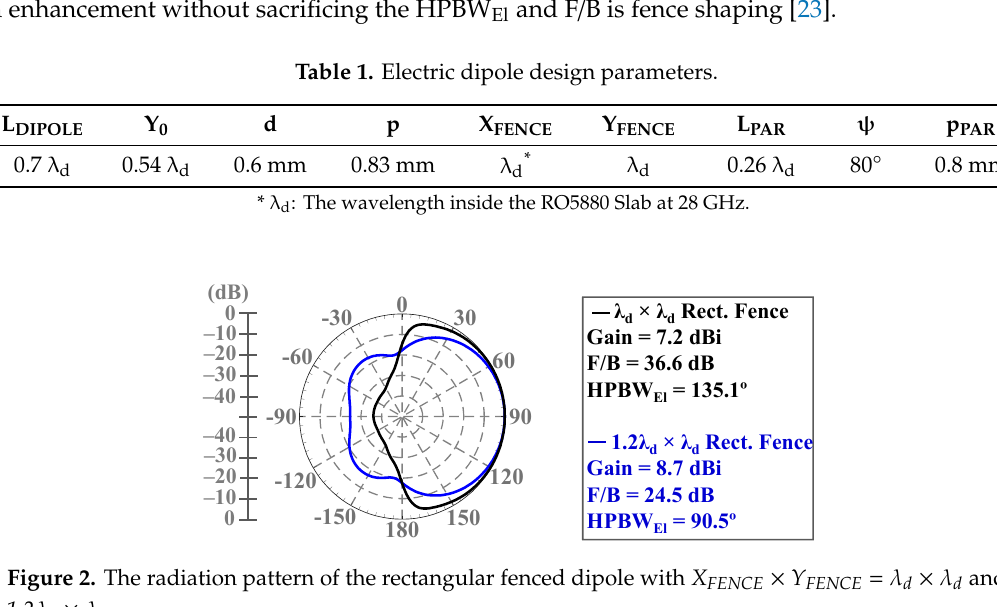
Figure 3. The simulated gain, HPBW El , and F/B versus the V-fence taper angle at 28 GHz, and the electric field at the dipole front face at θ T = 95° and 120°.